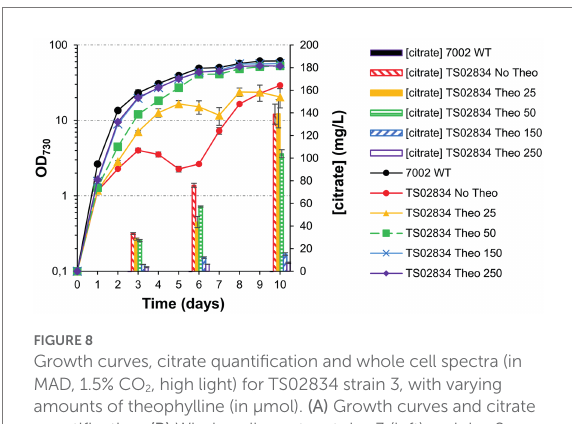
FIGURE 8 Growth curves, citrate quantification and whole cell spectra (in MAD, 1.5% CO 2 , high light) for TS02834 strain 3, with varying amounts of theophylline (in µmol). (A) Growth curves and citrate quantification. (B) Whole cell spectra at day 3 (left) and day 8